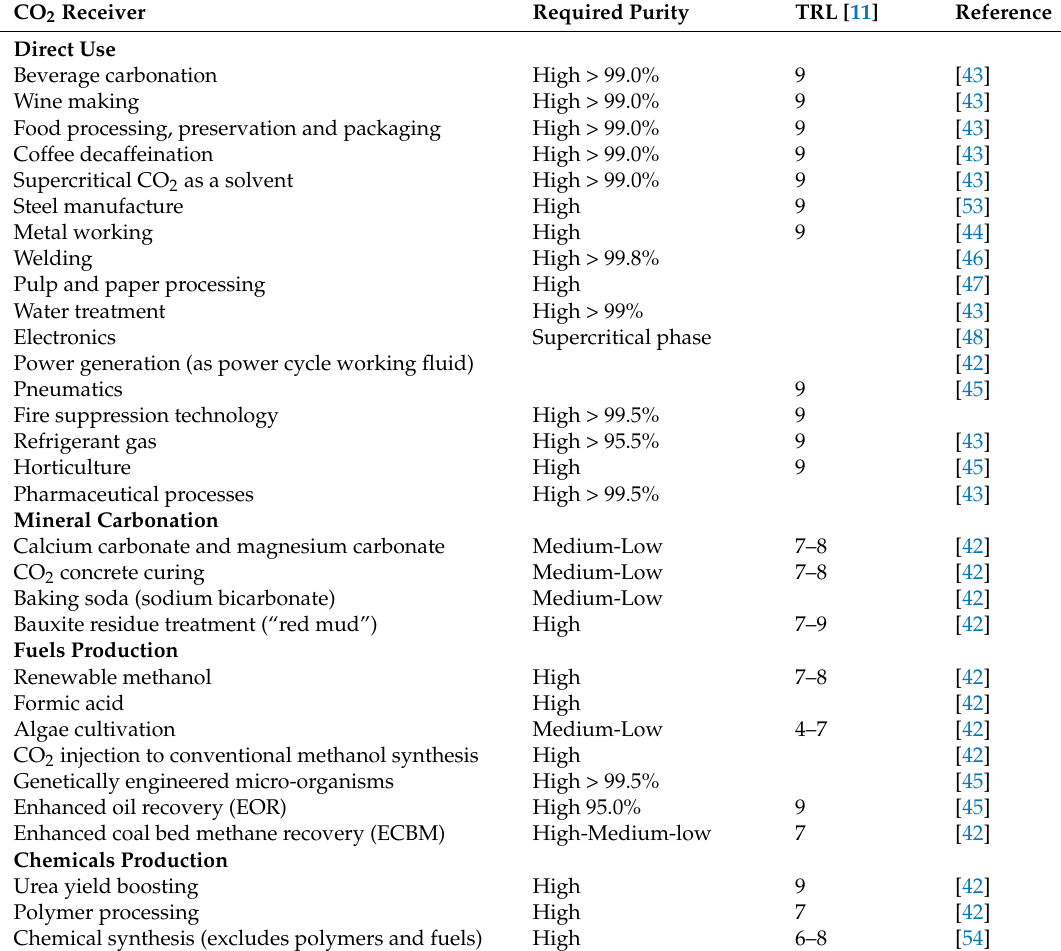
Table 2. Quality requirements of existing and emerging carbon dioxide (CO 2 )